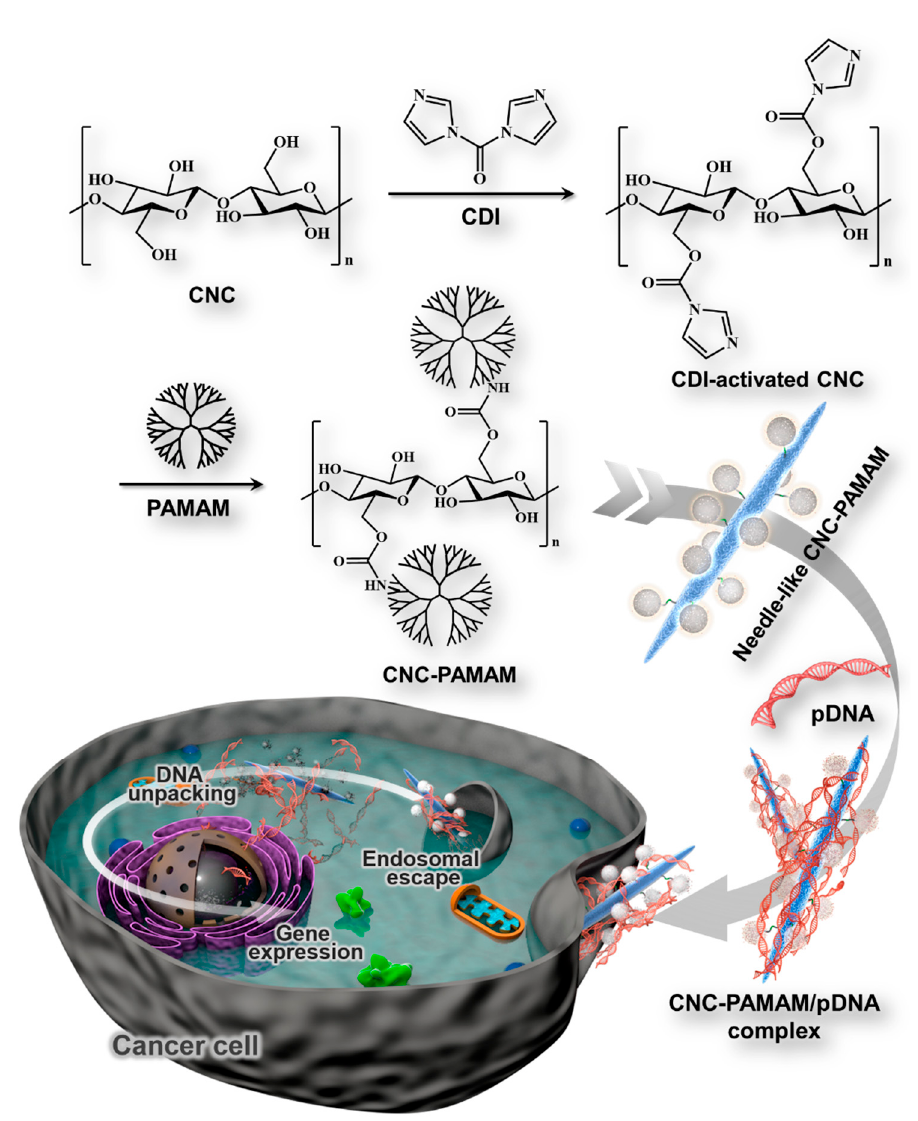
Figure 1. Schematic diagram illustrating the preparation of CNC-PAMAM and the resultant gene delivery process.